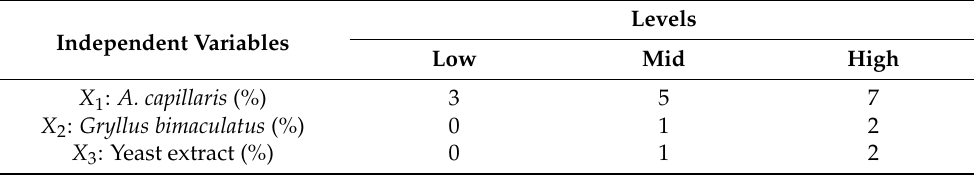
Table 1. Levels of independent variables in the Box–Behnken experimental design. Levels Independent Variables Low Mid High